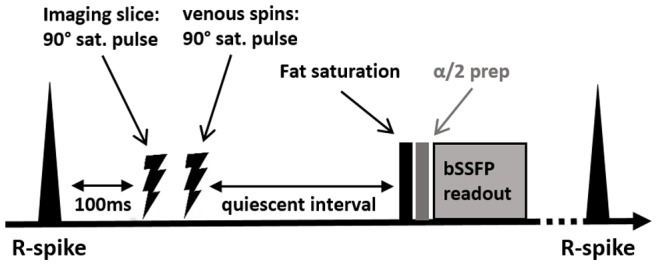
Pulse sequence diagram of the QISS sequence (modified after: Edelman RR et al., MRM 2009) [14].Saturation of imaging slice and tracking saturation of venous signal are applied 100 ms after the R-spike. The subsequent quiescent interval allows for inflow of non-saturated blood spins before a single-shot 2D image is acquired.